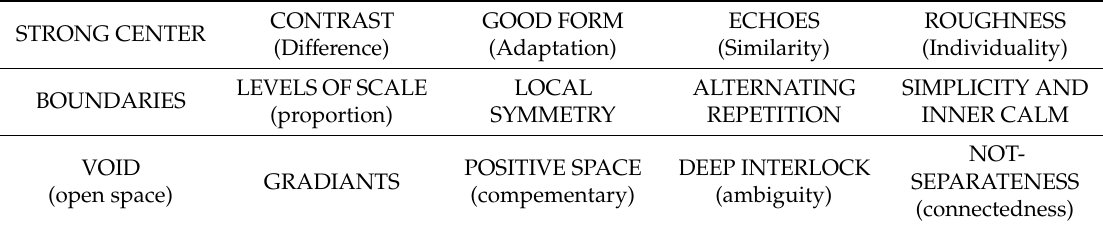
Table 1. Alexander’s 15 Properties of Living Systems per Helmut